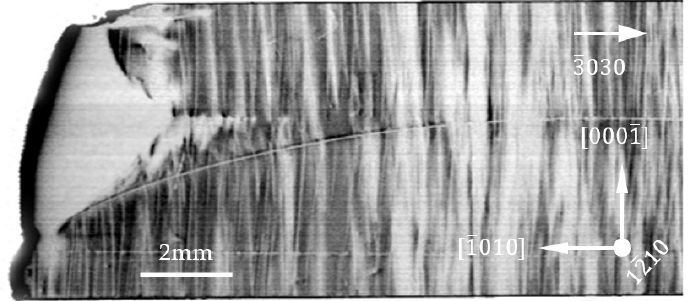
(cid:0) (cid:1) 1210 slice imaged using the 3030 reflection (Mo-K α 1 radiation).